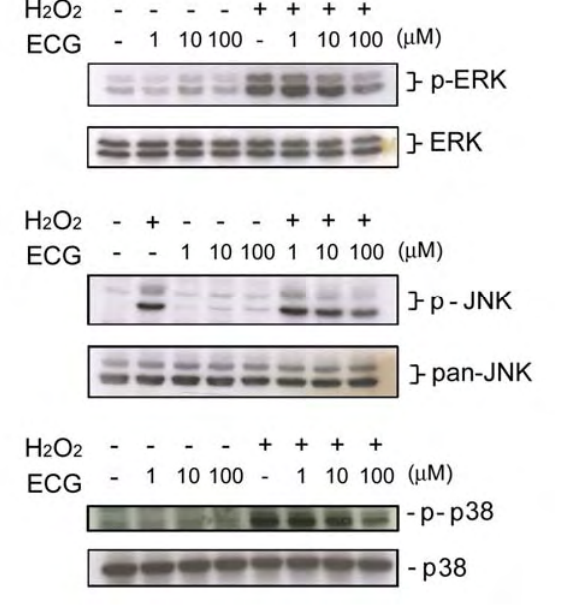
O -induced ERK1/2, JNK and p38 2 2